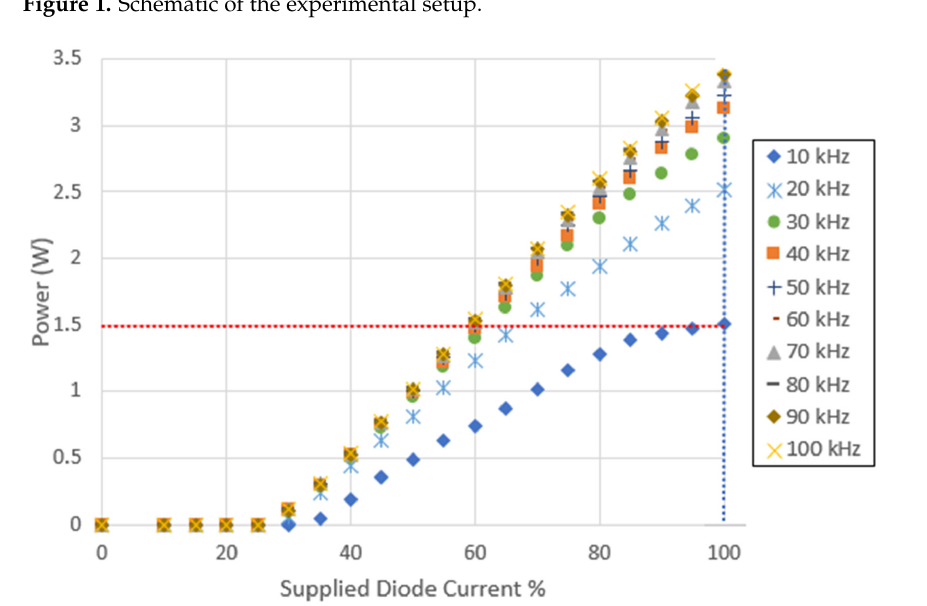
Figure 2. Power of laser ( PL ) for different repetition rates.